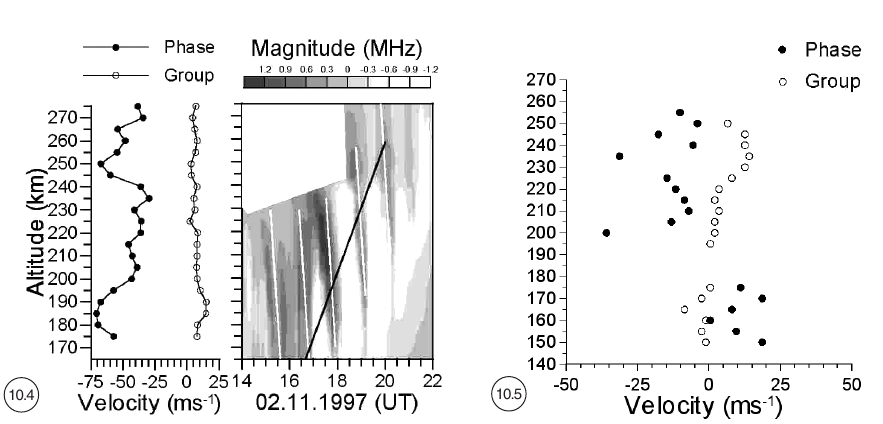
Fig. 10.4. Vertical structure of a GWS event caused by a cold front passage during 2 November 1997 as ob- served above Ebro station (40.8°N, 0.5°E). The left plot shows the vertical phase and group velocities of the wave packet with dominant period of 75 min as function of the altitude. The right plot shows the disturbance of this event caused in the plasma frequency as function of time and altitude, where the black line simulates the en- ergy progression of the wave with an averaged velocity of 8 ms -1 and the white lines simulate their phase pro- gression with an averaged velocity of − 47 ms -1 (adapted from Altadill et al., 1999). Fig. 10.5. Vertical structure of a GWS event observed during solar eclipse 11 August 1999 above Pr ° uhonice obser- vatory (49.9°N, 14.5°E). The plot shows the vertical phase and group velocities, time occurrence of central period of the wave packet with dominant period of 85 min as function of the altitude (adapted from S ˇ auli, 2001b).